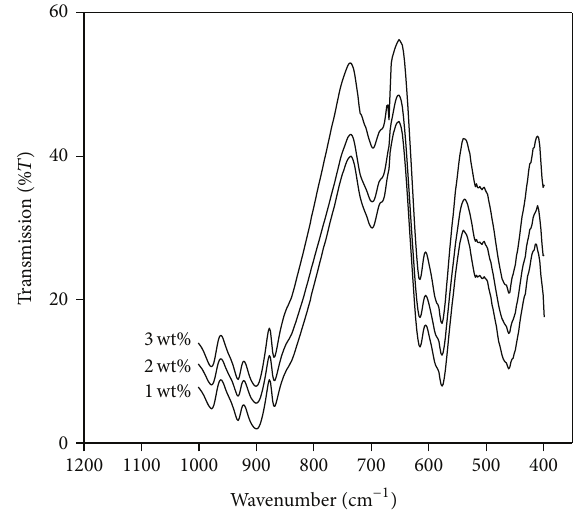
Table 3: Grain size of 3 wt% Eu ceramics sintered at different temperatures for